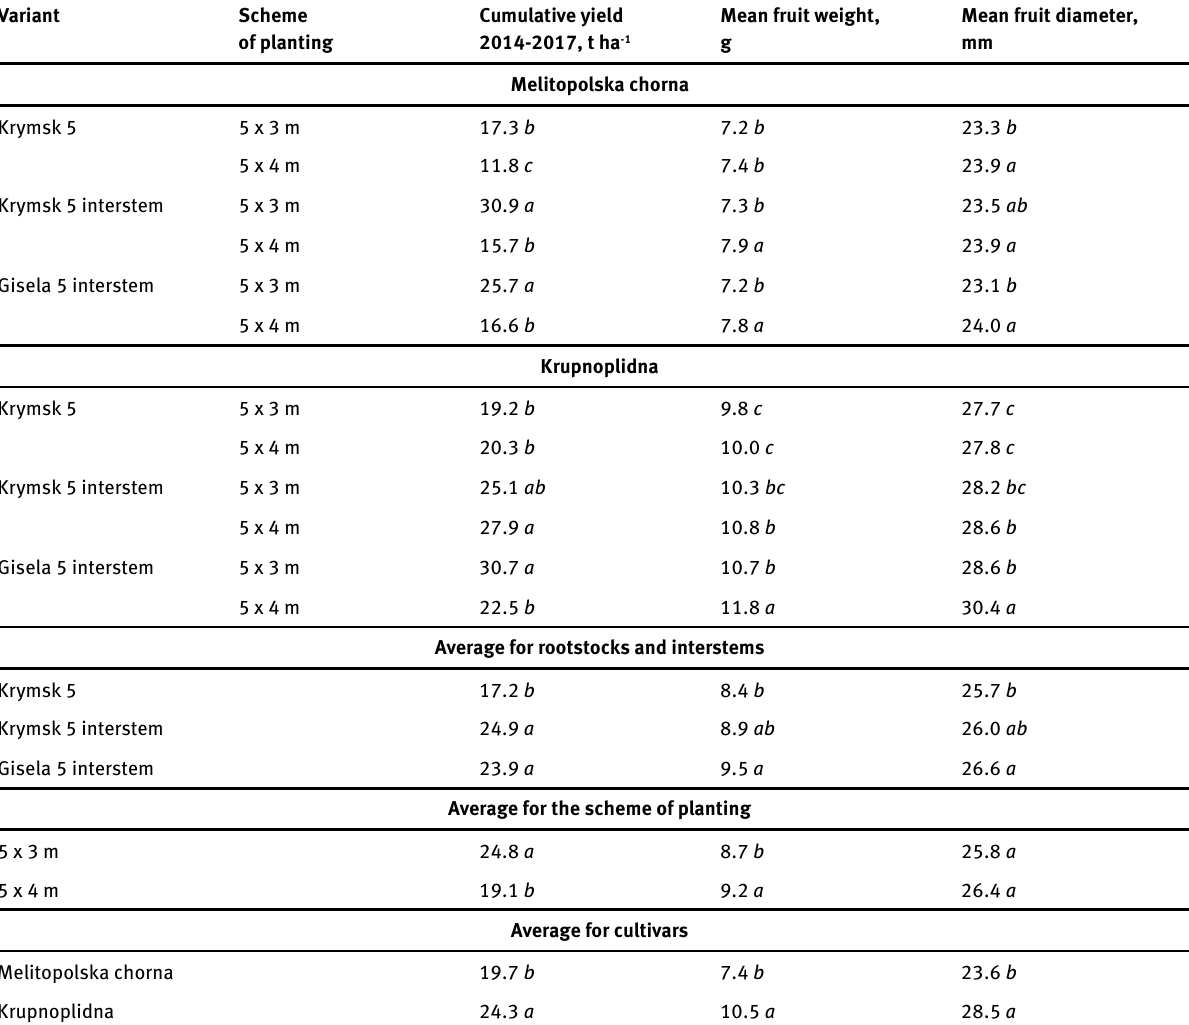
Table 3: Influence of interstems and plant density on yield and fruit quality of sweet cherry, average for 2014-2017